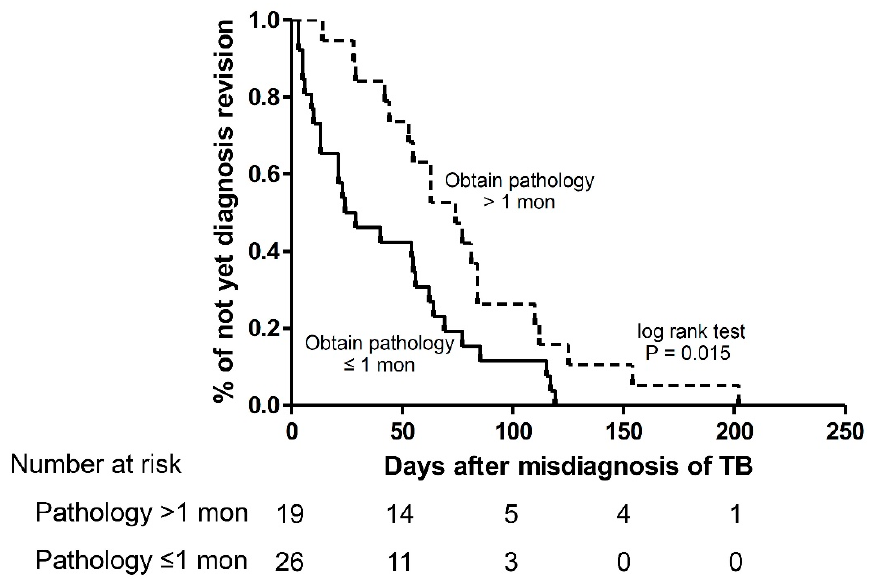
Figure 3. Kaplan Meier curve for time to revise diagnosis to lung cancer according to time to obtain pathology proof.